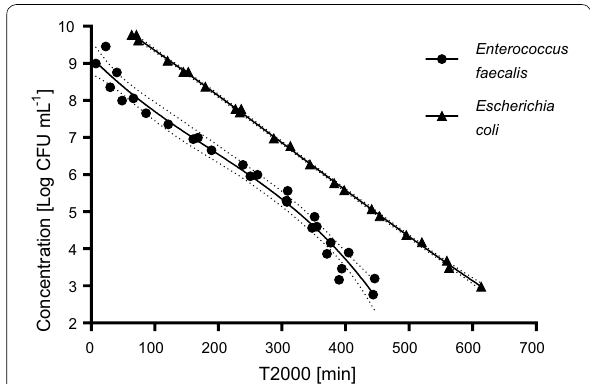
Fig. 3 Calibration curves describing the relationship between the concentration of the bacteria in the wells and the rate of resazurin metabolization. Depicted results are T2000 values compiled from the three independent experiments for both E. coli and E. faecalis . Dotted lines depict confidence intervals with a confidence level of 95%. T2000 values under the LOQ level (i.e. 10 3 CFU mL − 1 ) are not depicted in the